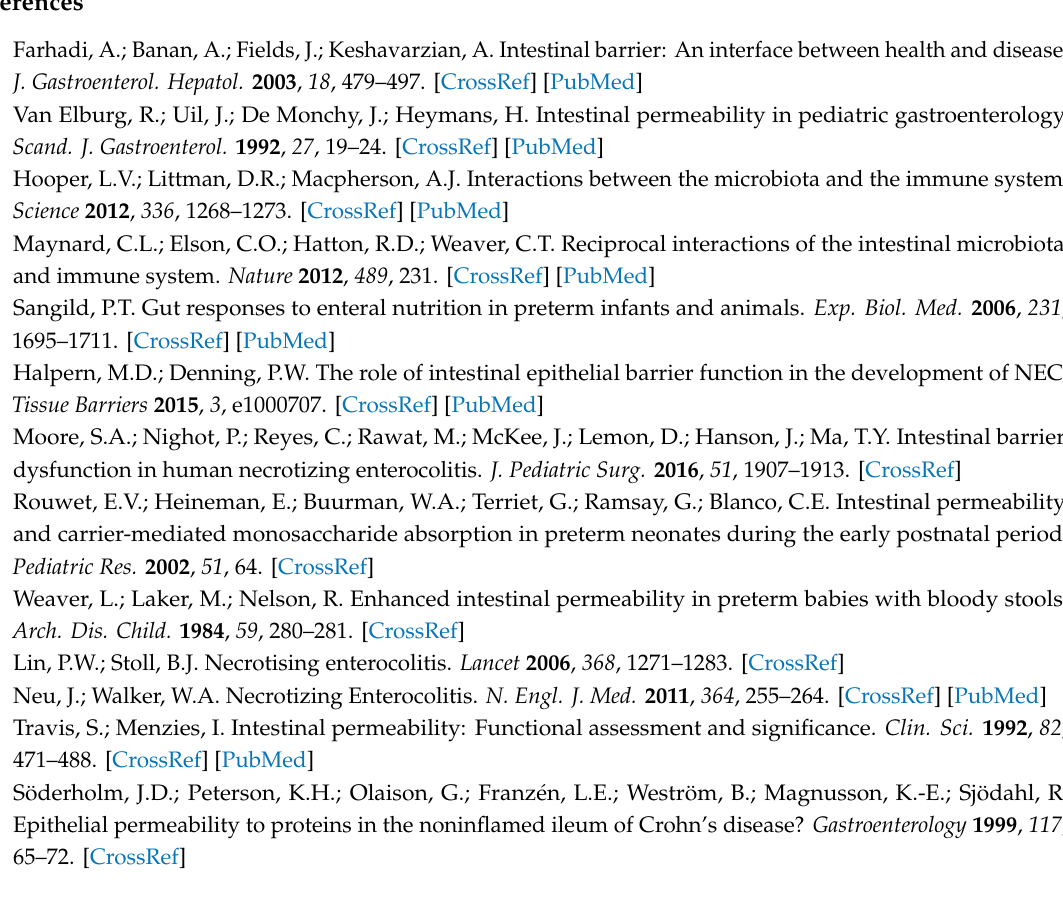
Figure S1: Leave-one-out cross validation for PLS model (a) and (b) plasma NMR data, (c) and (d) urine NMR data. (a) Q 2 value for PLS on plasma data, and (b) RMSECV for PLS model on plasma data. (a) Q 2 value for PLS on urine data, and (b) RMSECV for PLS model on urine